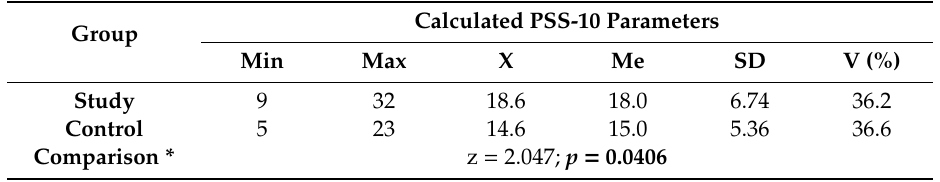
Table 2. Comparison of PSS-10 results in the study and control groups.